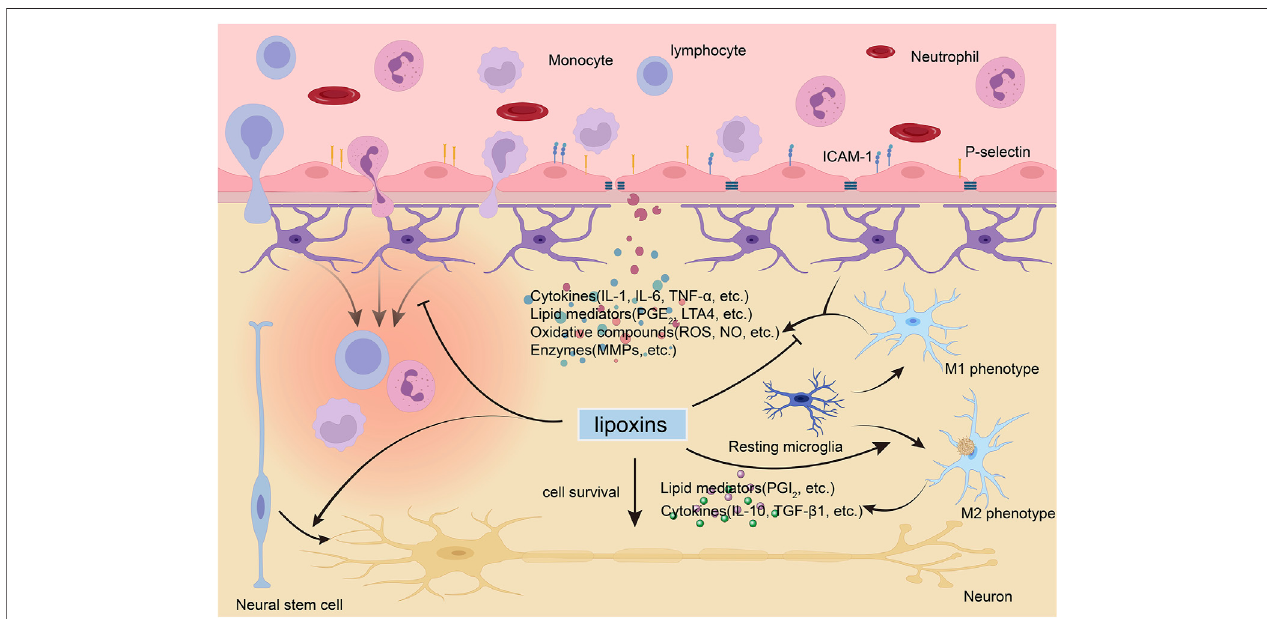
FIGURE2 | Lipoxins (LXs) exert protective and modulatory actions in the brain. During neurological diseases, theblood-brain barrier (BBB) is disturbed and allows circulating immune cells and proteins to enter the brain. LXs can inhibit the activation and migration of immune cells (Liu et al., 2019), modulate activated endothelial leukocyte interactions (Smith et al., 2015), and maintain the integrity of the BBB by suppressing the expression of proin fl ammatory mediators and matrix metallopeptidases (MMPs) (Wu et al., 2012b; Hawkins et al., 2014). LXs can modulate glial cell activity to block harmful cytokine release (Wang et al., 2011; Wu et al., 2012a; Yao et al., 2014) and switch activated microglia to the anti-in fl ammatory, tissue-repairing M2 phenotype instead of the proin fl ammatory, tissue-damaging M1phenotype(Taetzschetal.,2015).LXscanalsopromotethesurvivalofneurons(Zhuetal.,2020)andinductedthedifferentiationofneuralstemcelltoneurons(Wada et al., 2006). ICAM, intercellular cell adhesion molecule-1; IL, interleukin; LT, leukotriene; NO, nitric oxide; PG, prostaglandin; ROS, reactive oxygen species; TGF- β 1, transforming growth factor β 1; TNF, tumor necrosis